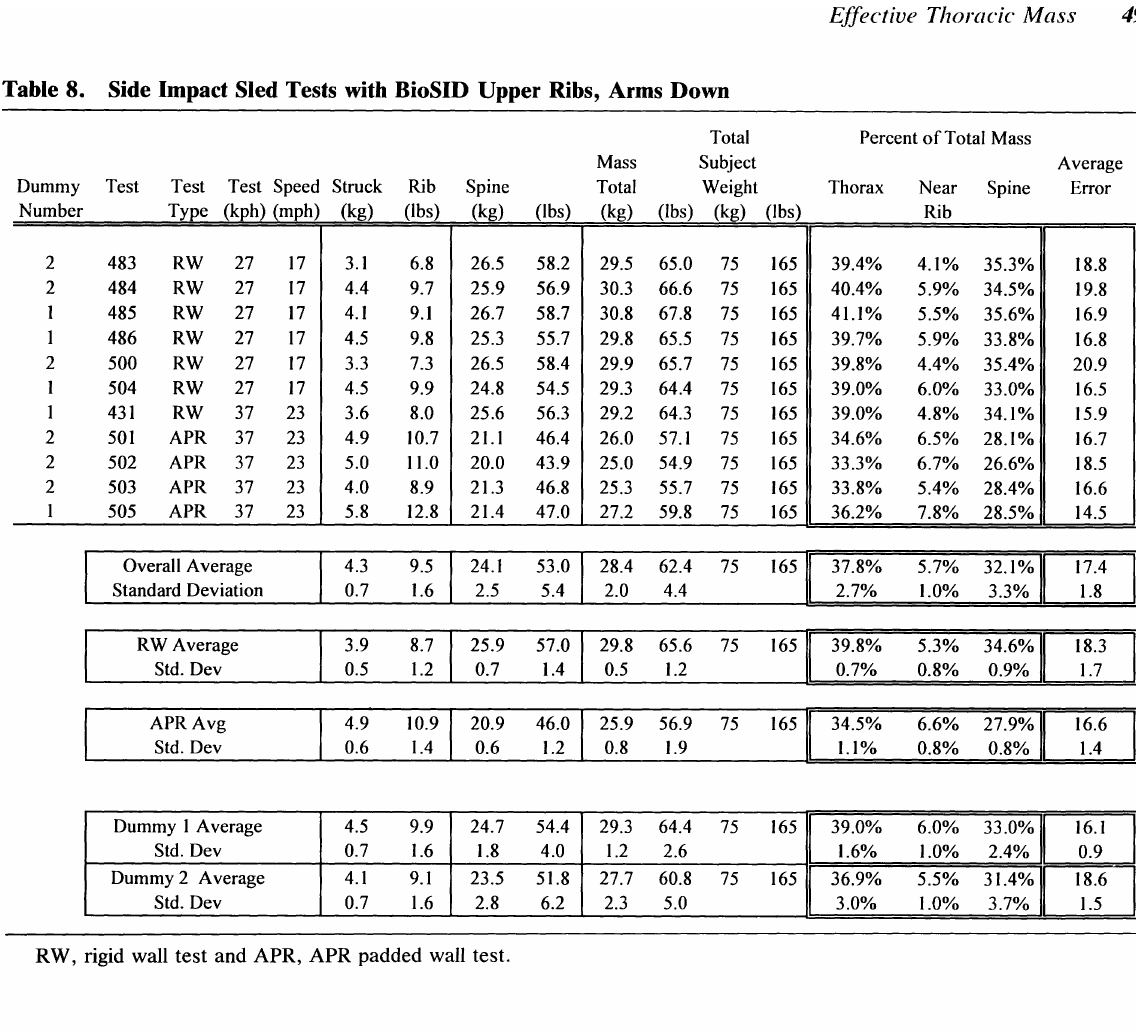
Table 8. Side Impact Sled Tests with BioSID Upper Ribs, Arms Down